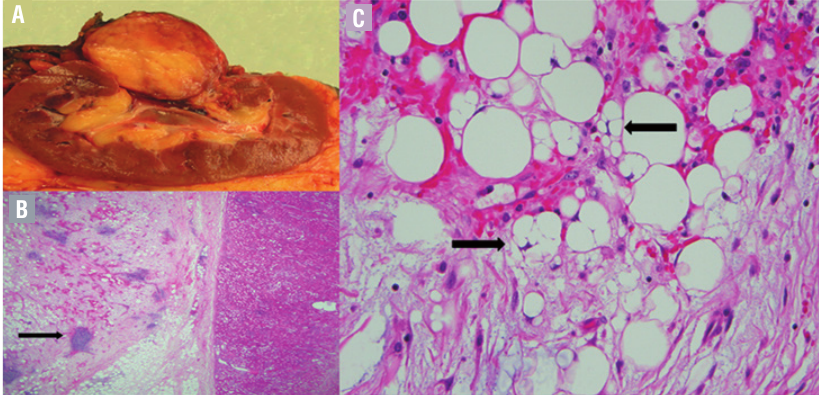
Figure 3 - histopathology. a) Gross: bivalved kidney with well circumscribed tumor near hilum. b) Microscopic, 20x: sclerotic adipose tissue with foci of chronic inflammation (arrow), c) Microscopic, 400x: multivacuolated pseudolipoblasts (arrows).